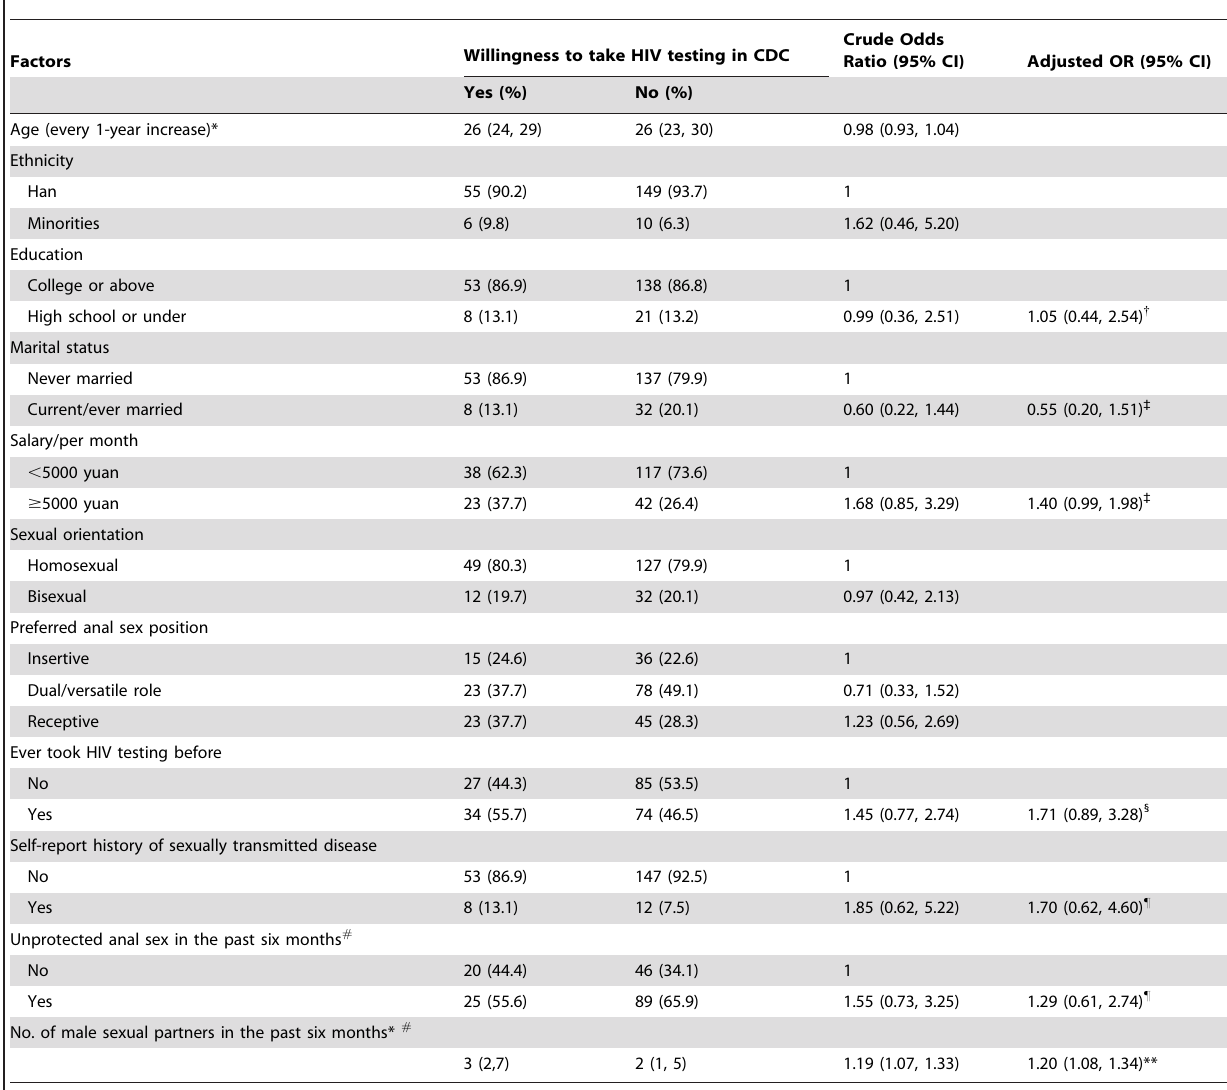
Table 3. Factors associated with willingness to go to local CDC for taking HIV testing among Chinese men who have sex with men.